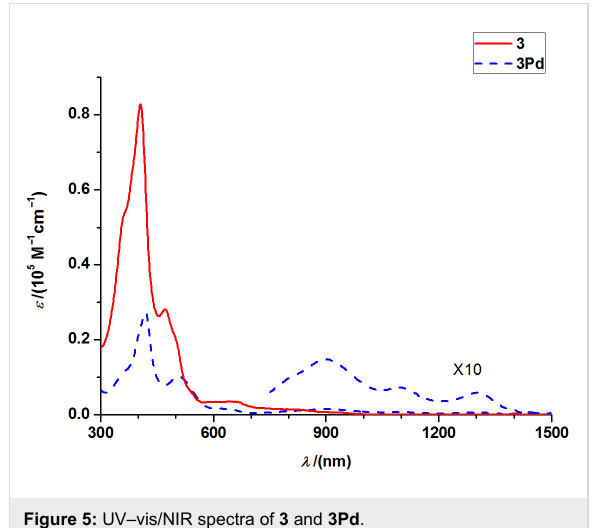
Figure 5: UV–vis/NIR spectra of 3 and 3Pd